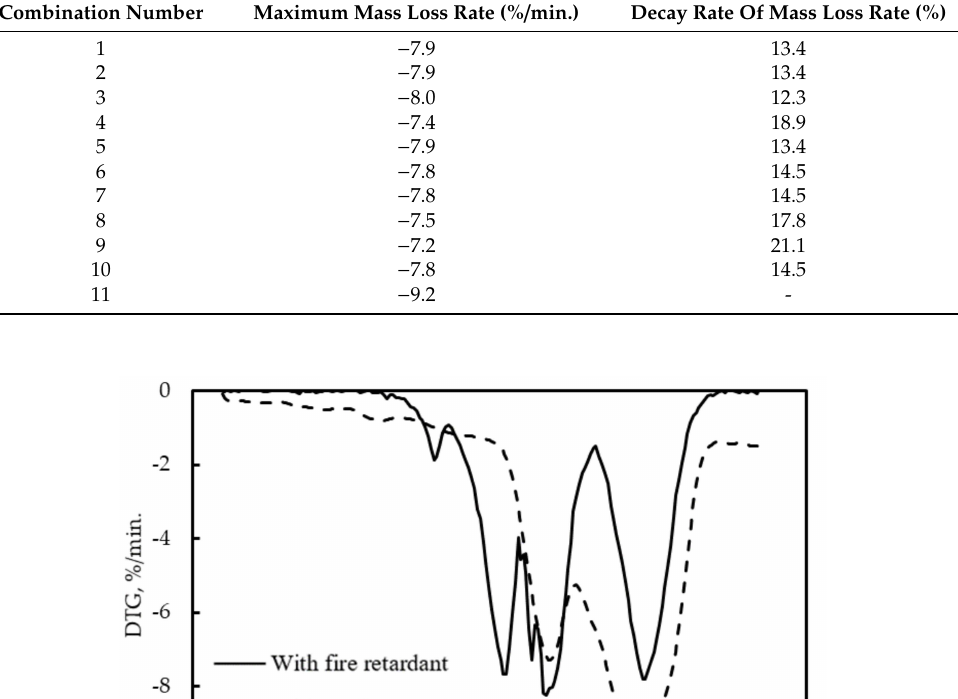
Table 4. Decay rate of mass loss rate of the asphalt.